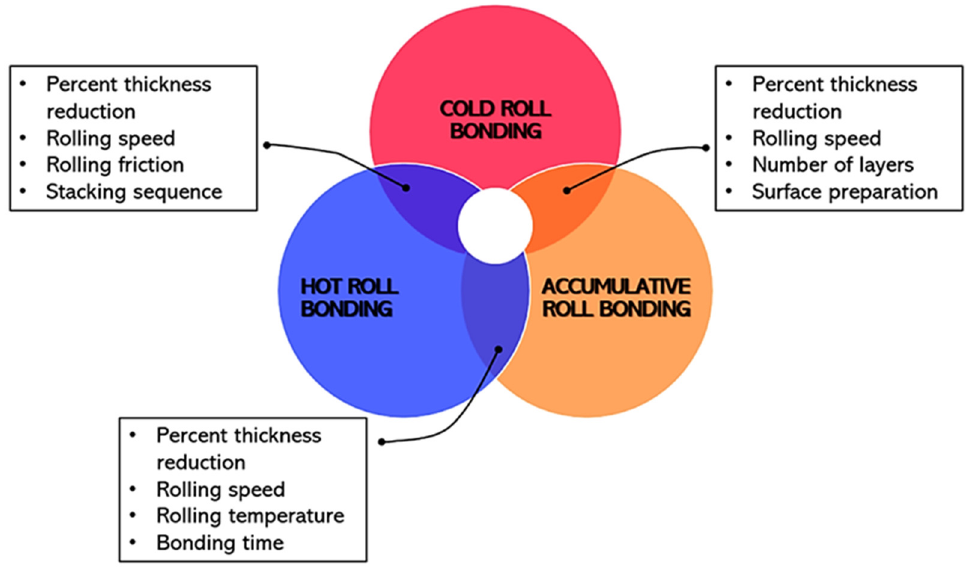
Figure 3. An overview of the similarity variables with regard to process parameters in RB processes.